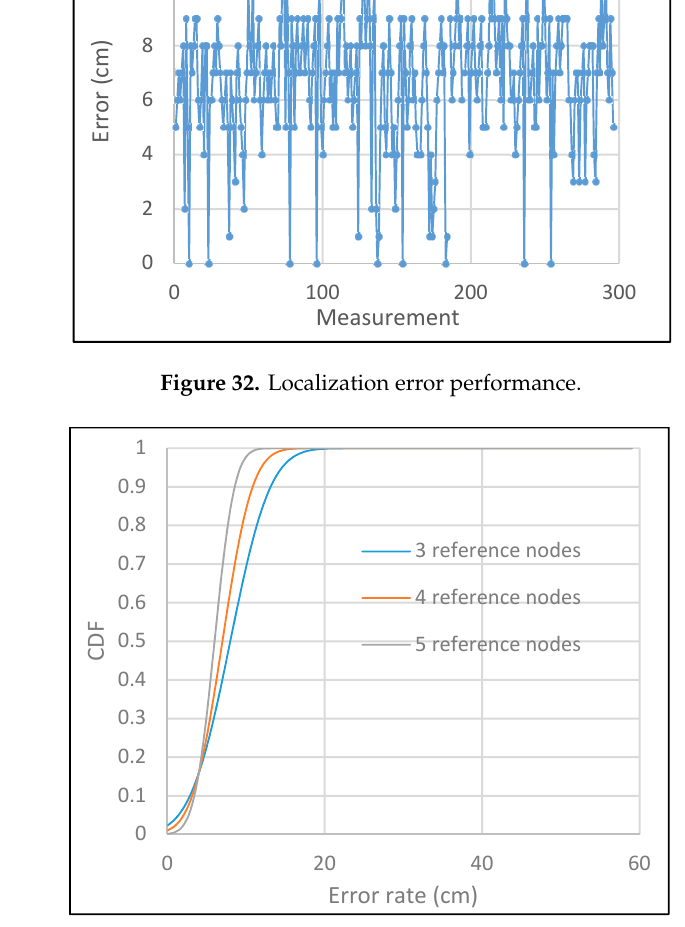
Figure 33. CDF performance of localization.